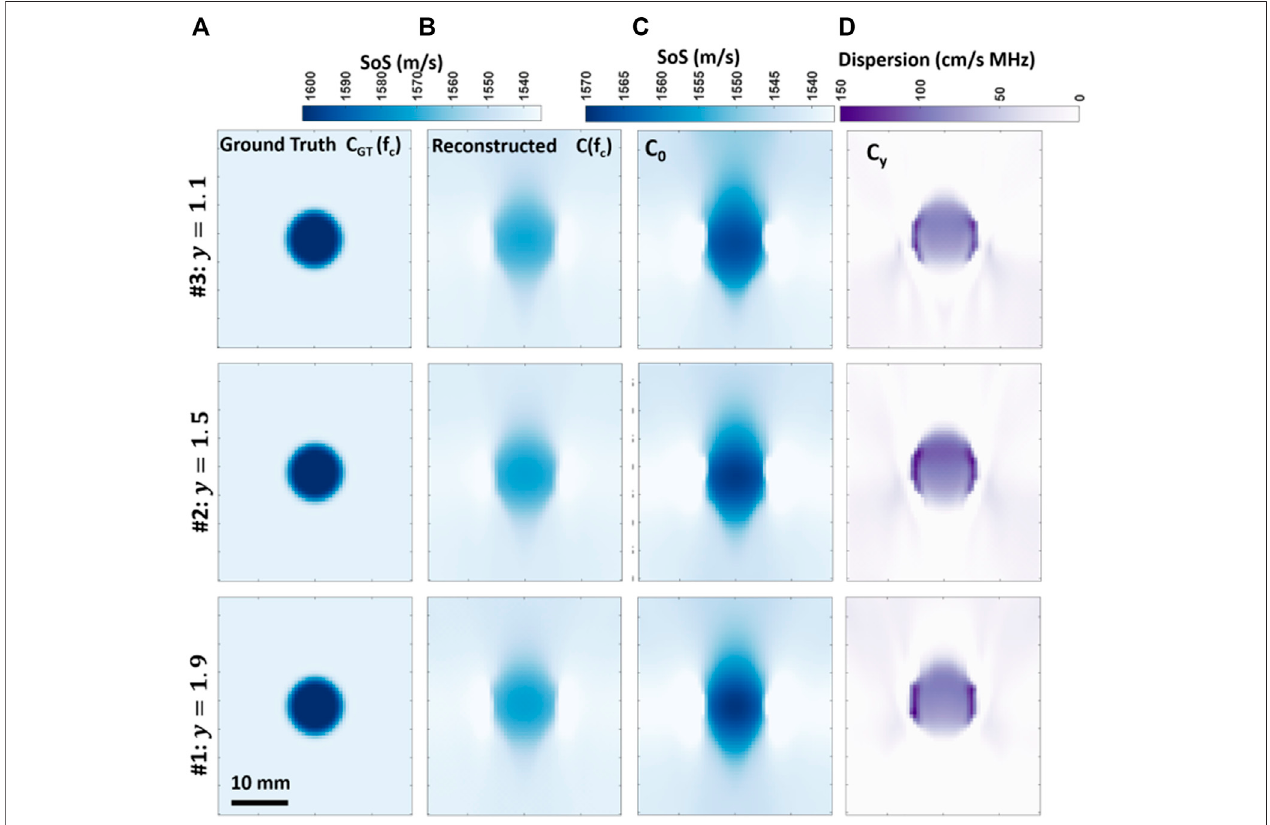
FIGURE 4 | Comparison of frequency-dependent SoS imaging for the three different simulations with y = {1.1, 1.5, 1.9} in each row, with columns from left to right (A-D) : ground-truth SoS maps c GT ( f c ) at the center frequency f c = 5 MHz; reconstructed SoS maps c ( f c ) at the center frequency; reconstructed c 0 maps; and reconstructed c y